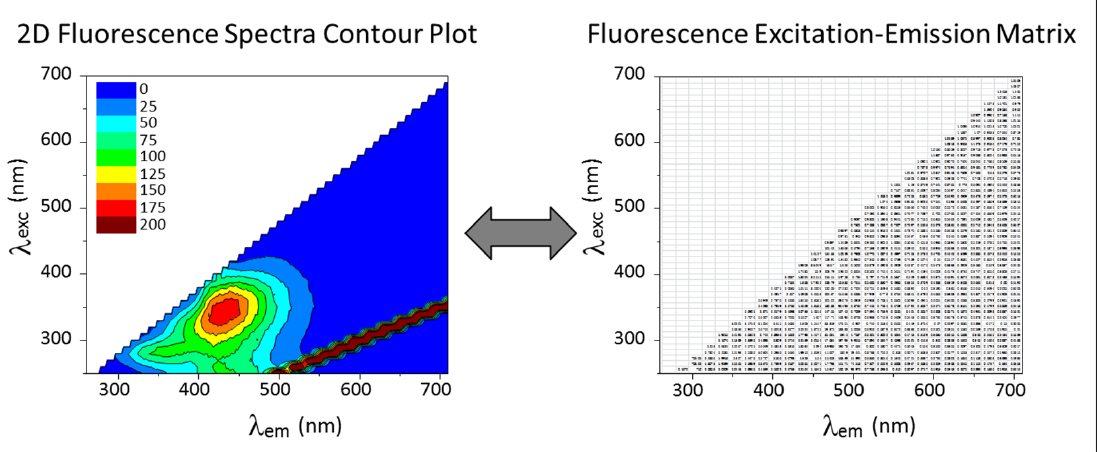
Figure 2. Two-dimensional fluorescence spectra represented as a contour plot ( left ) and as a numerical matrix ( right ).